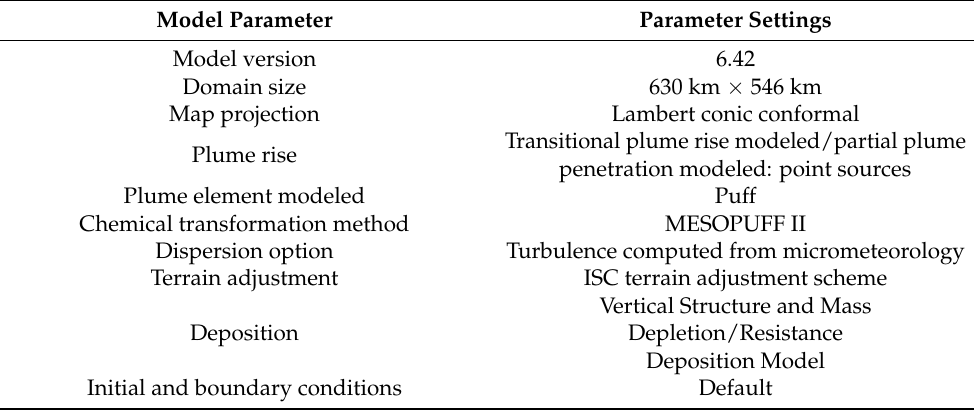
Table 3. Main parameters used in CALPUFF.